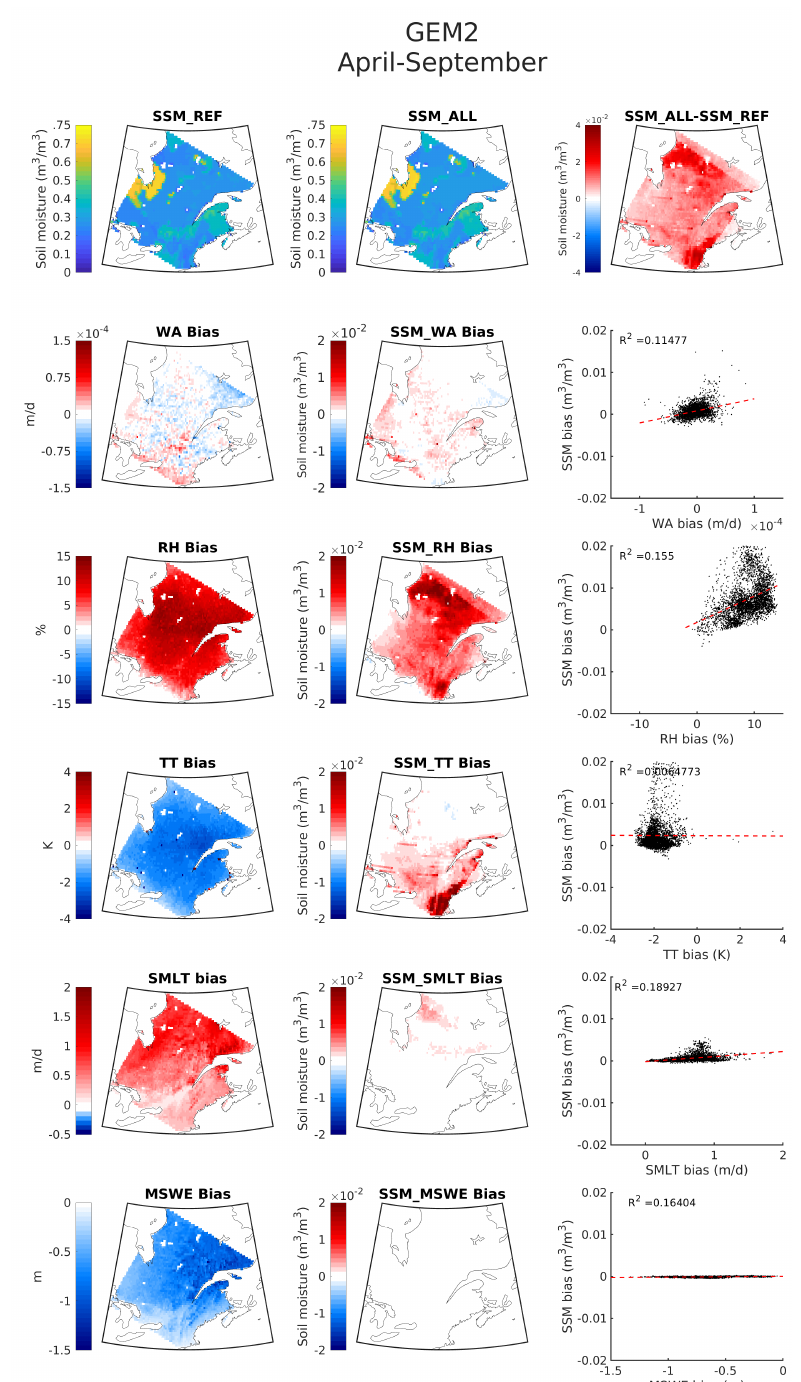
Figure 10. RF2 emulated SSM when using ERA5 predictors ( top left panel), GEM2 predictors ( top center panel) and their difference ( top right panel) for the 1989 − 2020 period. GEM2 predictor biases when compared with ERA5 ( left column). SSM biases when replacing ERA5 climate predictors with those from GEM2 in RF2. Scatter plots of SSM bias against predictor bias are presented in the right